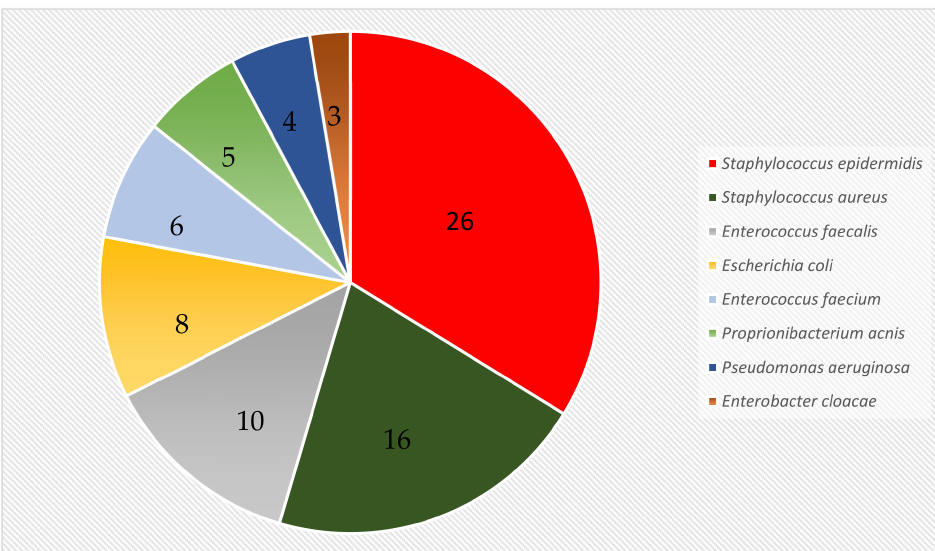
Figure 2. Microbiological results of 43 patients with implant-associated infections after surgical treatment of fractures of the pelvis and the acetabulum. Two thirds of infections were polymicrobial; 36 different bacteria and fungi were detected. The eight most frequent bacteria are